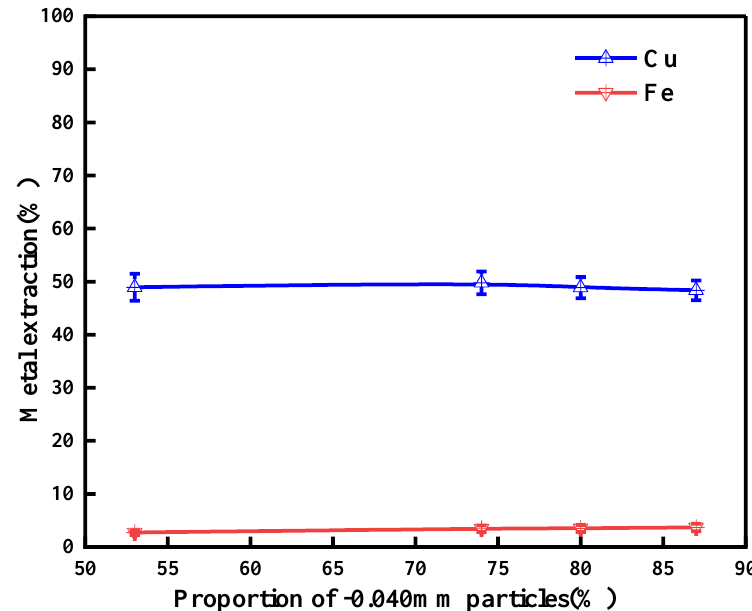
Figure 8. Effect of particle size on metal extractions in agitation leaching.